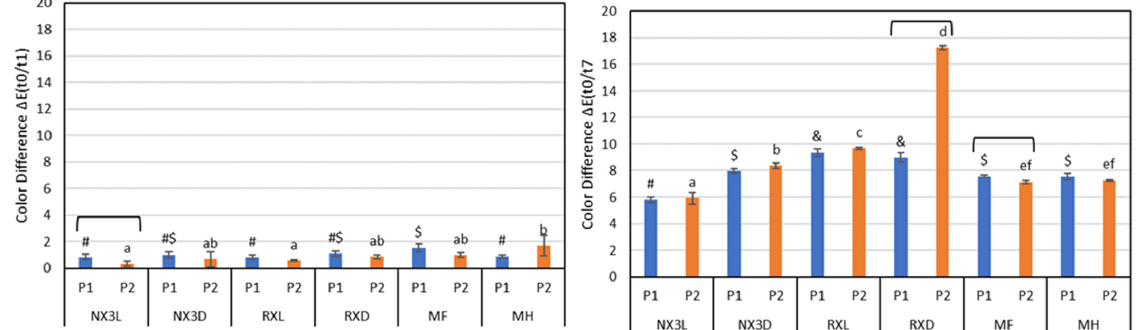
Figure 2. ∆ E(t0/t1) and ∆ E(t0/t7) results of tested resin luting agents cured with traditional curing protocol (P1) and step luting protocol (P2). Different letters identify statistical differences between P1 groups. Different symbols (#, $ and &) identify statistical differences between P2 groups. Bars identify a statistical difference between P1 and P2 ( p < 0.05). NX3L = NX3 light-cure, NX3D = NX3 dual-cure, RXL = RelyX Veneer, RXD = RelyX Ultimate, MF = Enamel Plus HRi Flow, MH = Enamel Plus